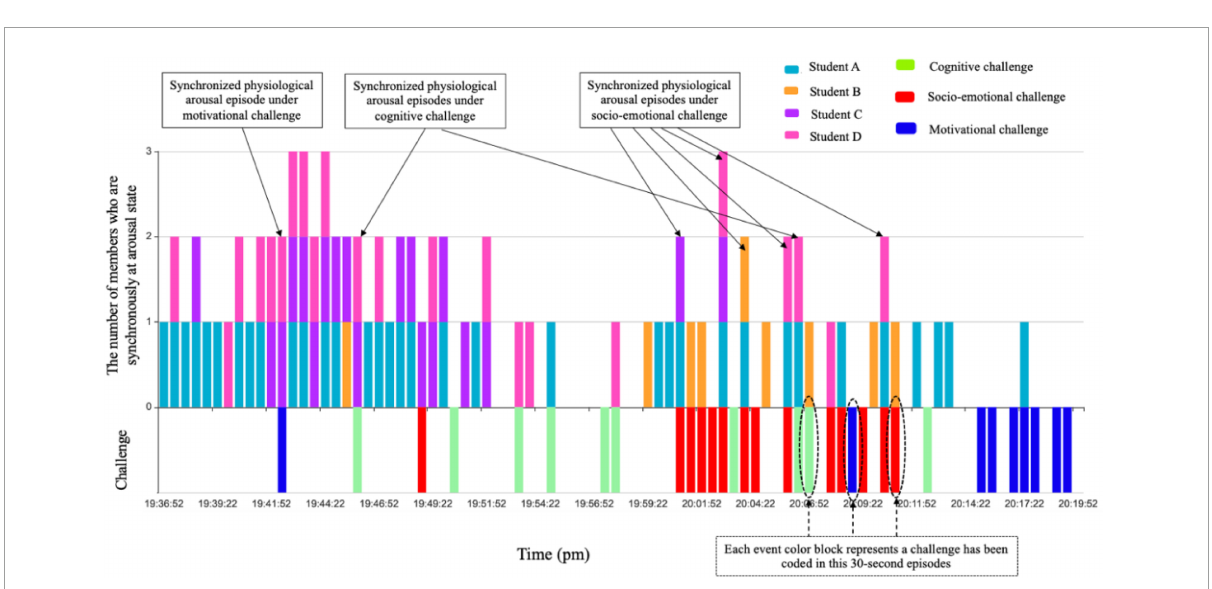
FIGURE5 How group members’ physiological arousal synchronized under different challenges (example of group 4. The episodes where two or more arousal color blocks and event color blocks are superimposed are synchronized physiological arousal episodes under